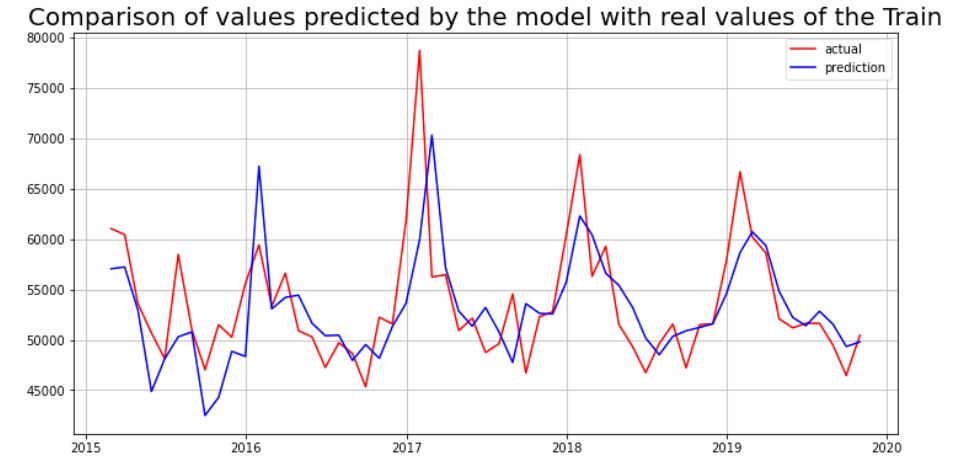
Figure 11. Autocorrelation function graph for the time series of total Italian’s deaths